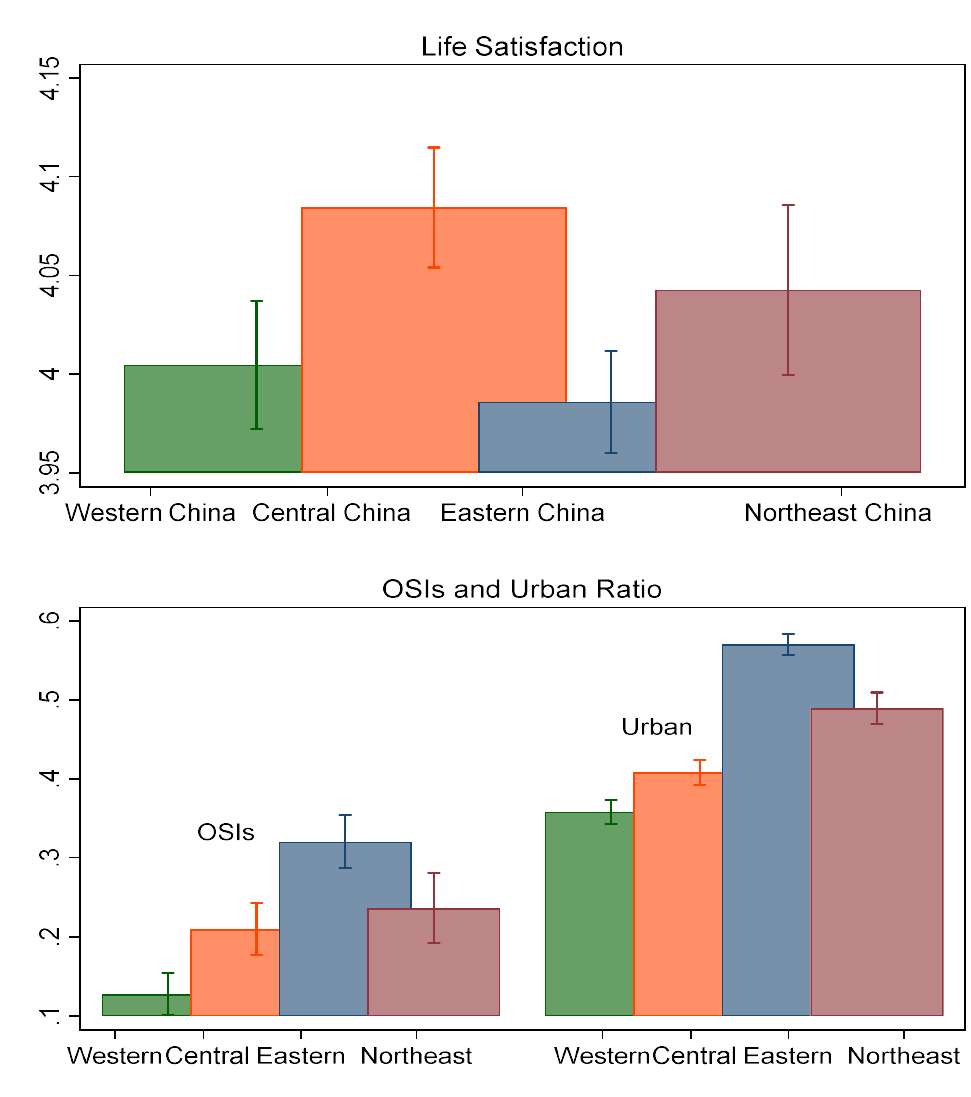
Figure 3. Average values of life satisfaction, OSIs, and urban proportion of older Chinese adults in different geographical areas.